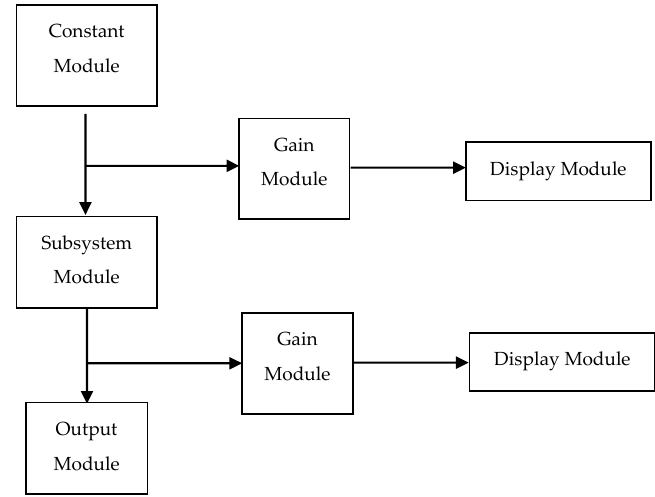
Figure 2. The flowchart of the Simulink platform.